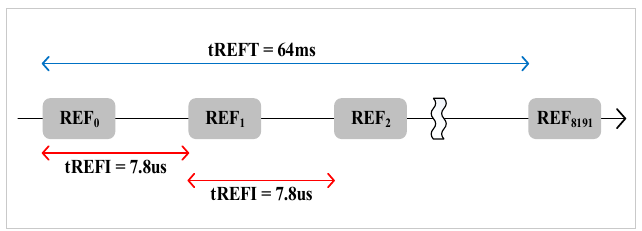
Figure 3. All rows are refreshed by 8K refresh commands.